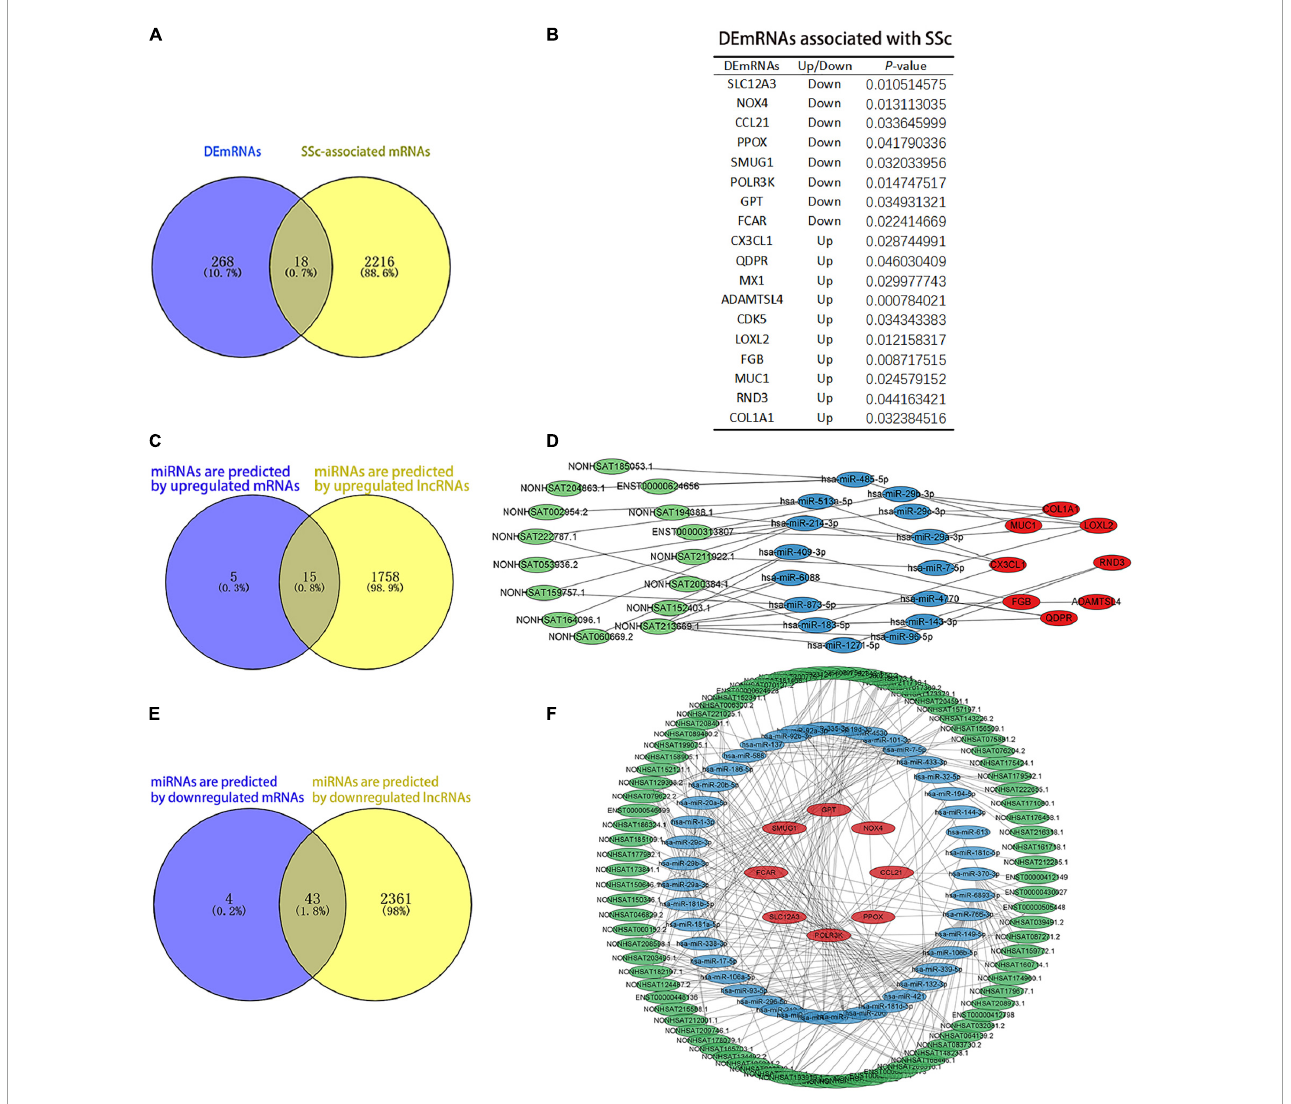
FIGURE6 Analysis of competing endogenous RNAs (ceRNAs) networks. (A) The blue and yellow parts are Venn diagrams. The blue part shows the DEmRNAs obtained by sequencing. The yellow part is the mRNAs predicted by the DisGeNET and GeneCards databases, and the middle part represents the overlapping DEmRNAs of the two groups. (B) The table of DEmRNAs related to SSc. (C,D) Upregulated ceRNA network. Panel (C) the blue and yellow parts are Venn diagrams. The blue part shows the miRNAs that are predicted by upregulated mRNAs. The yellow part shows the miRNAs that are predicted by upregulated lncRNAs. Panel (D) green parts are upregulated lncRNA, blue parts are miRNAs that interact with lncRNA and mRNA, and red parts are upregulated mRNA. (E,F) Downregulated ceRNA network. Panel (E) the blue and yellow parts are Venn diagrams. The blue part shows